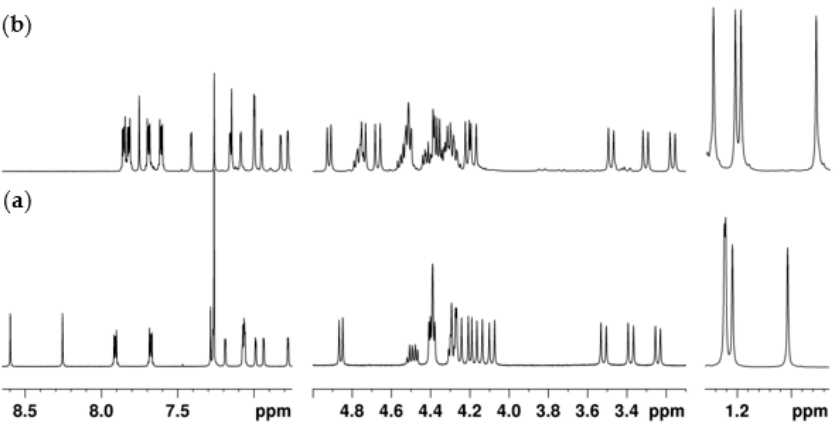
Figure 3. 1 H NMR spectra (500 MHz, CDCl 3 , 22 °C) of compounds: ( a ) 5a and ( b ) 6a